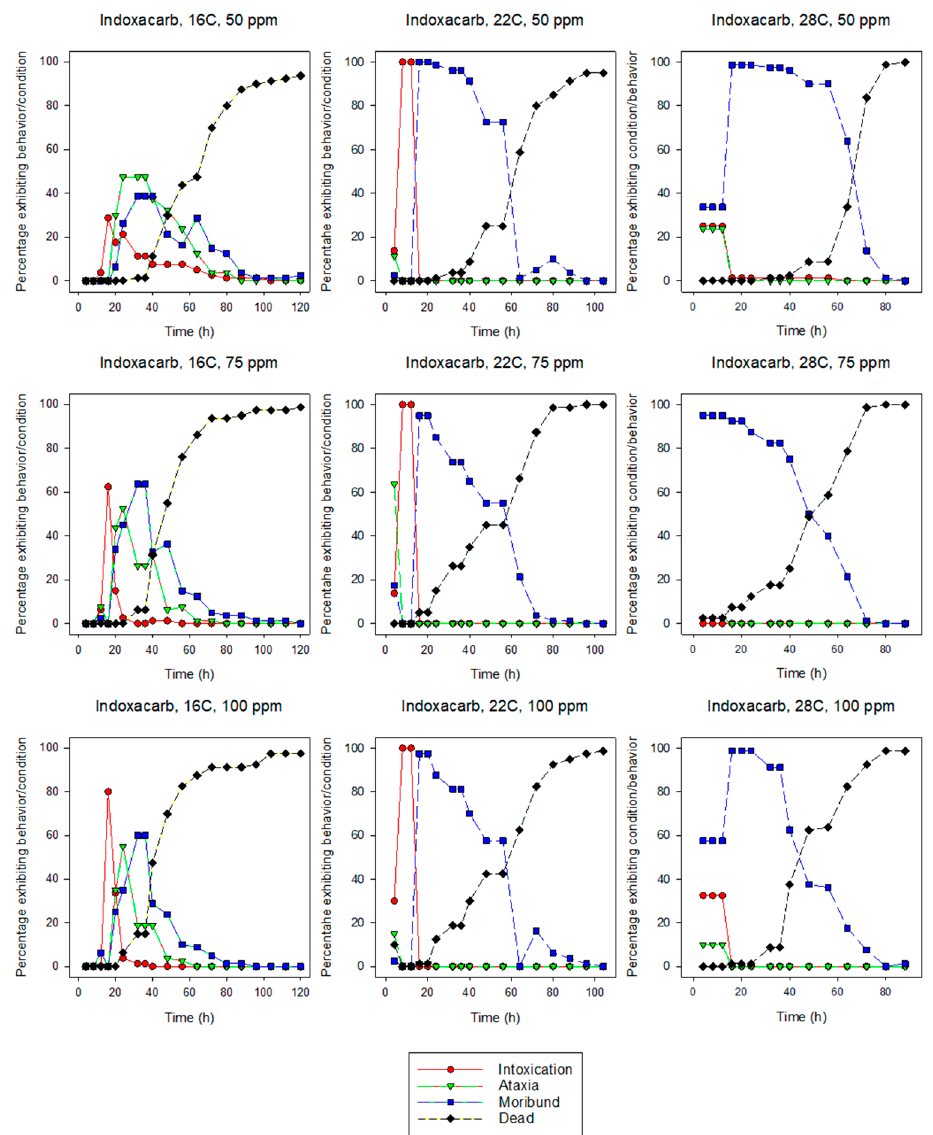
Figure 4. Effects of concentration and temperature on the behaviors of indoxacarb-exposed Formosan subterranean termites, C. formosanus .